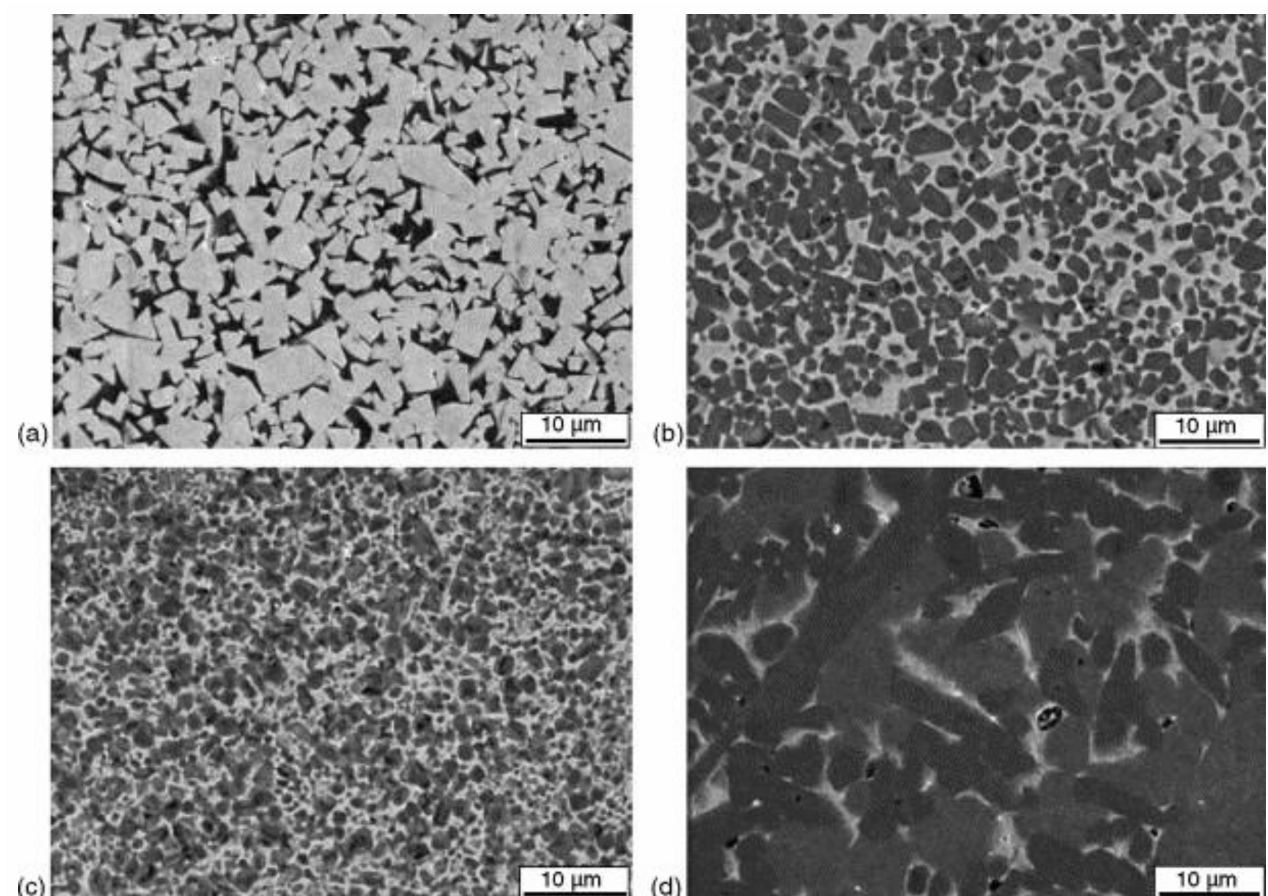
Figure 1. Microstructures of WC-Co hardmetal ( a ) and TiC–FeNi ( b ), TiC–NiMo ( c ) and ( d ) Cr 3 C 2 – NiMo cermets